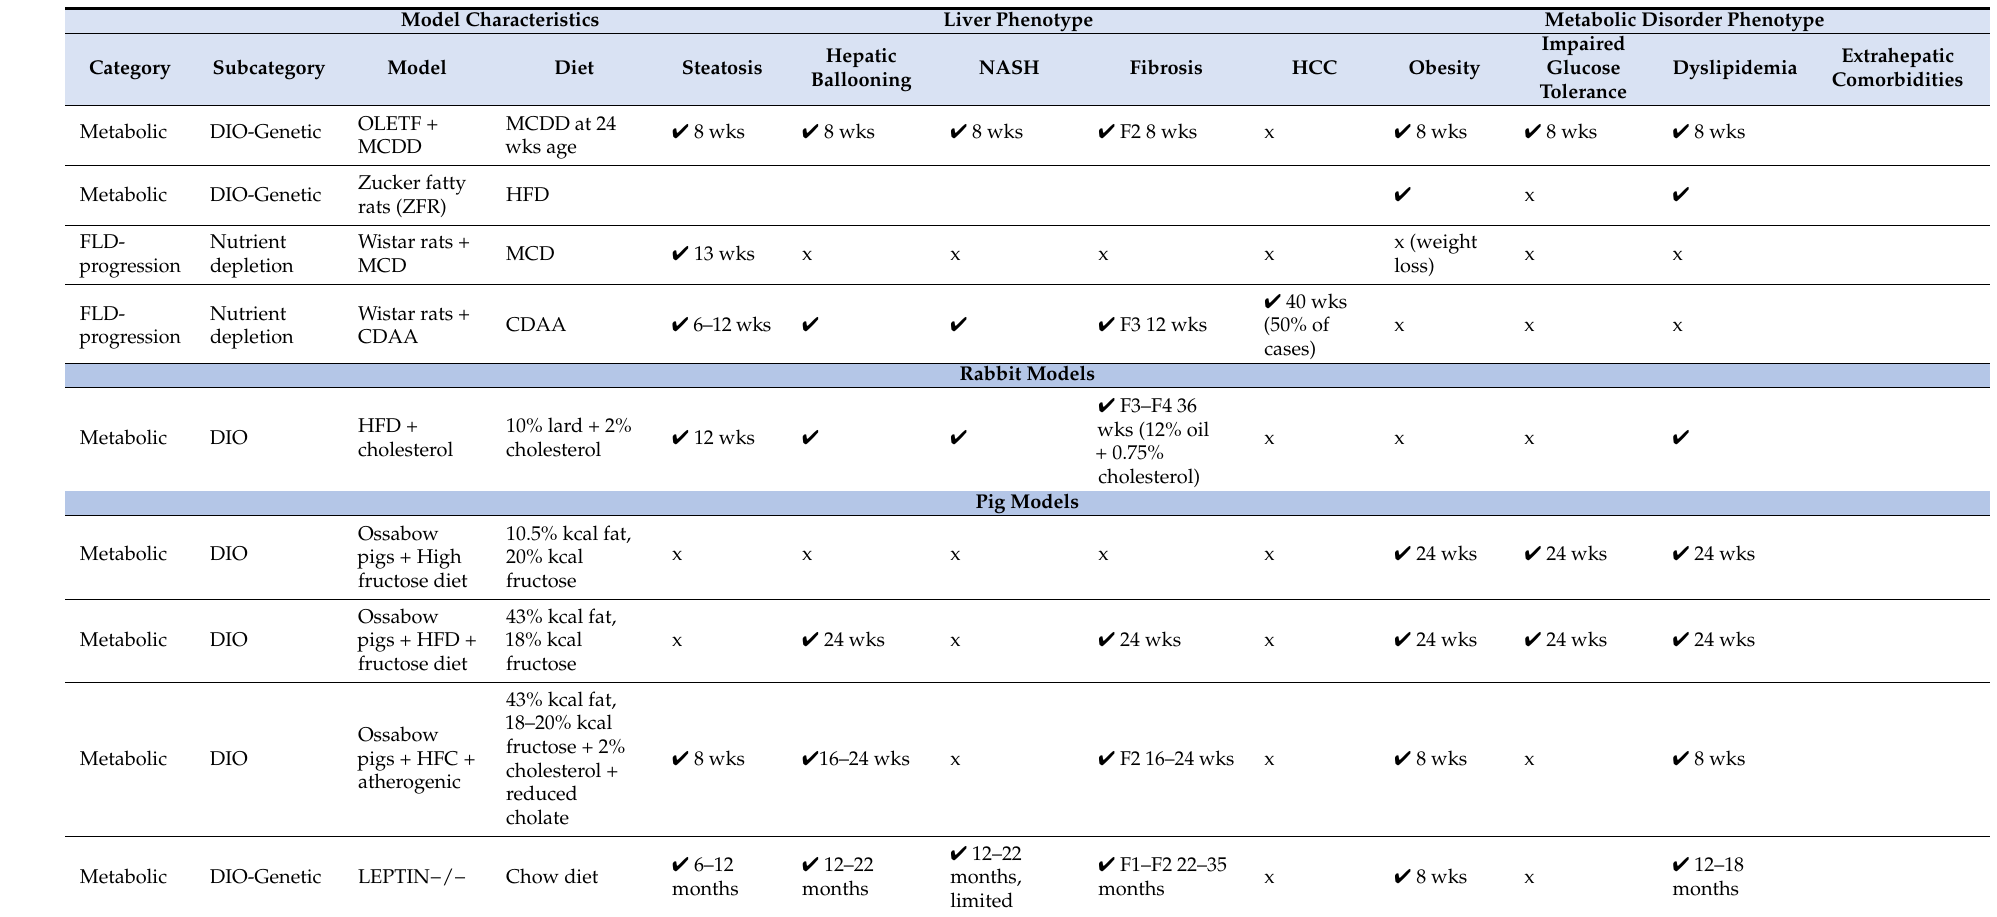
Table 1. Cont. Model